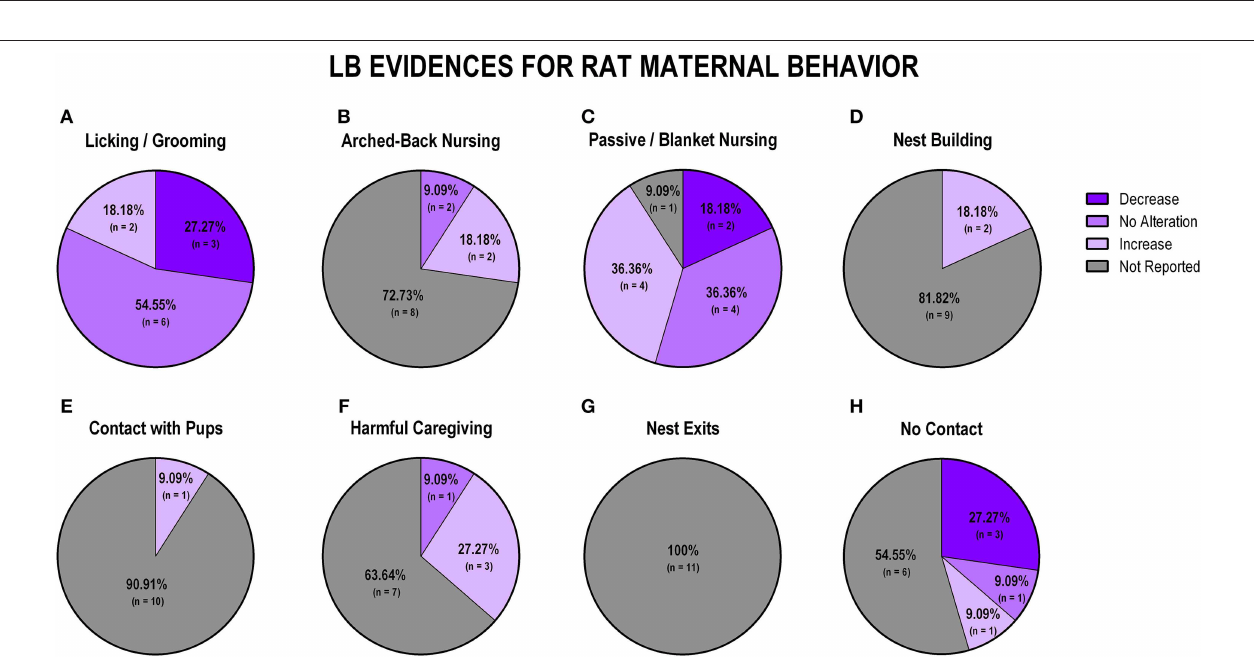
FIGURE 7 | Percentage of behavior findings from LB rat studies. Licking and grooming behavior (A) . Arched-back nursing behavior (B) . Passive and blanket nursing behavior (C) . Nest building behavior (D) . Contact with pups behavior (E) . Harmful caregiving behavior (F) . Nest exits behavior (G) . No contact behavior (H) .